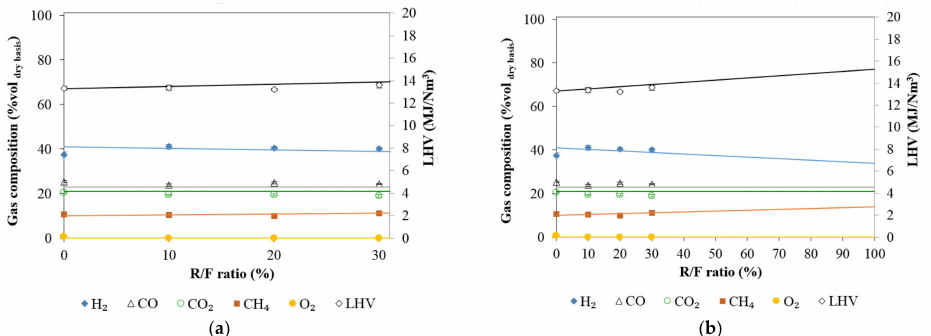
Figure 12. Influence of R/F ratio on the main product gas composition: ( a ) R/F ratio from 0–40% and ( b ) R/F ratio from 0–100%. The trend lines are from the IPSEpro simulation